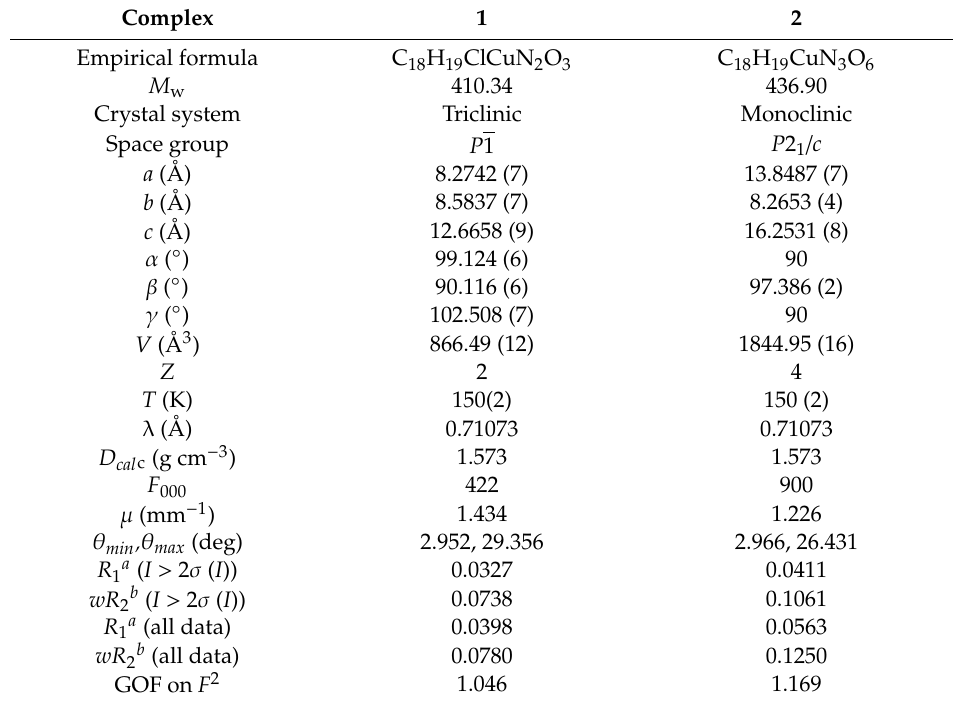
Table 1. Crystallographic data for 1 and 2 .